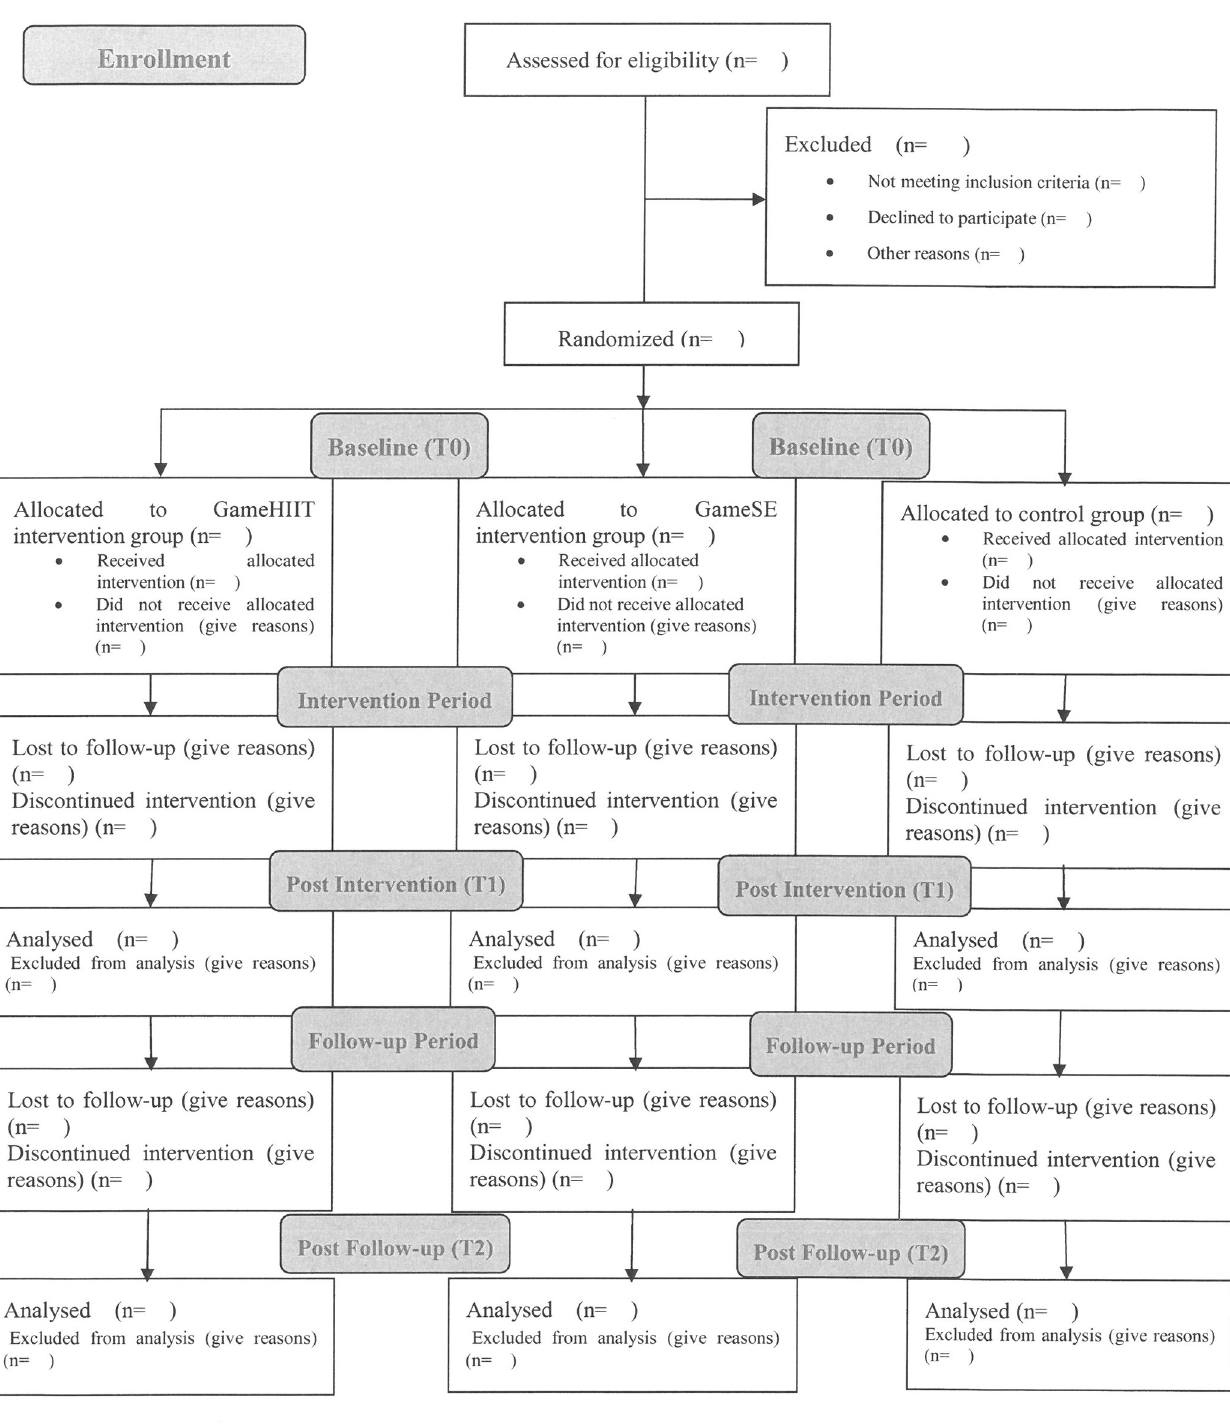
Fig 2. Flow diagram of the